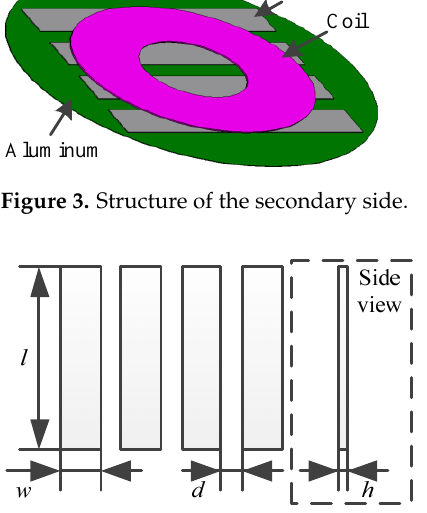
Figure 4. Structure of the strips of the inner layer of the shield.